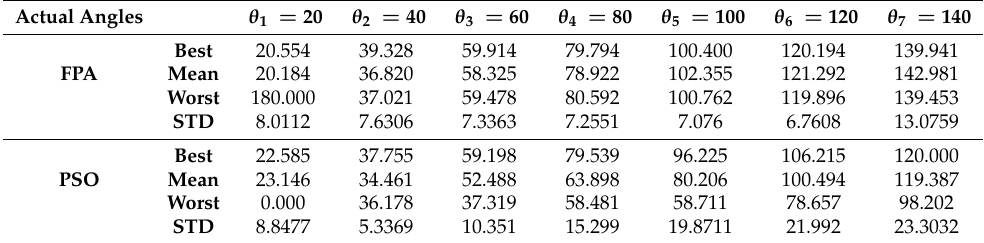
Table 1. Estimation accuracy and STD for seven targets at SNR = 0 dB.